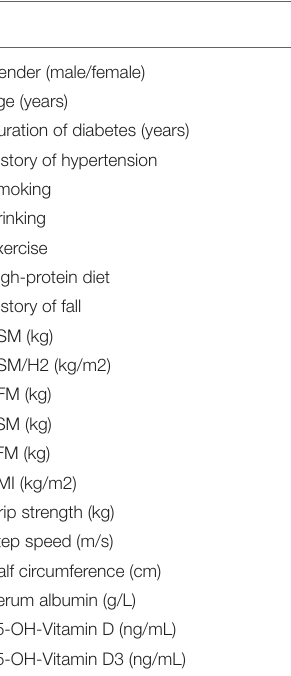
TABLE 1 | Baseline characteristics of